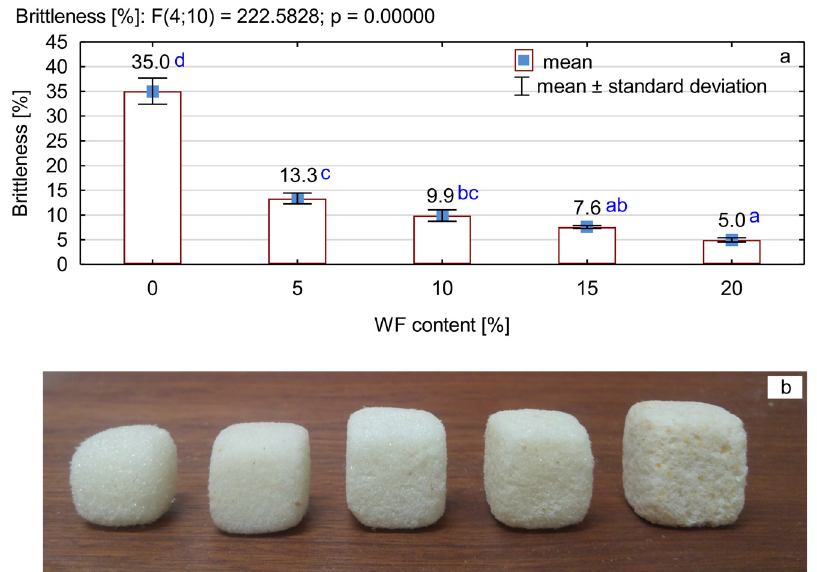
Figure 9. Brittleness of PUR foams with the addition of different amounts of WF: ( a ) average brittleness values of the tested foams, ( b ) image of the foams after the brittleness test (from left to right, an increase in the WF content). Different letters in colour indicate homogeneous groups of mean values determined by one ‐ factor ANOVA with Tukey’s test.